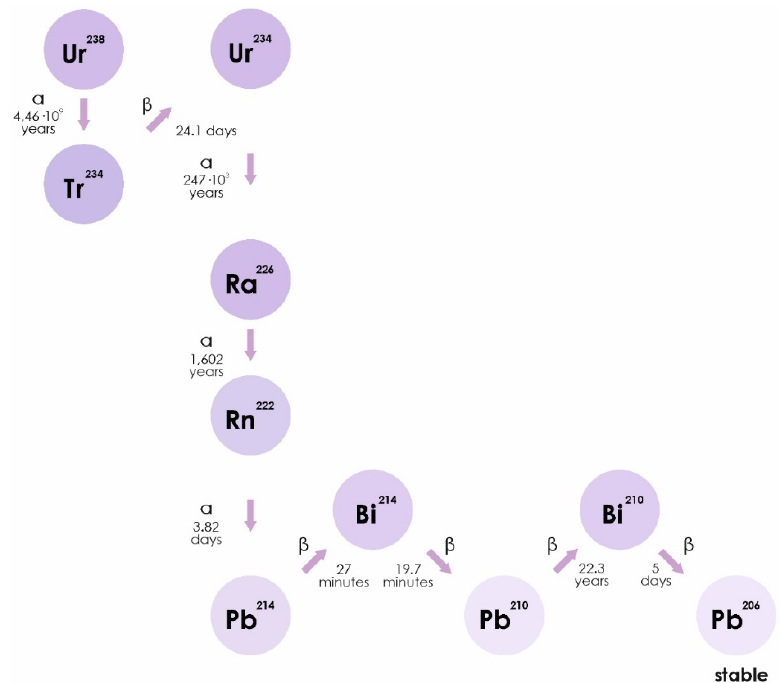
Figure 1. The isotope 222 Rn is a direct decay product of radium-226 ( 226 Ra), which is part of a decay series beginning with uranium-238 ( 238 U). Thorium-230 and -234 ( 230 Th and 234 Th) are also part of this decay series. 222 Rn includes a series of decay: 222 Rn ( α ) → 218 Po ( α ) → 214 Pb → 214 Bi → 214 Po ( α ) → 210 Pb, and is any combination of half-lived radon progeny.